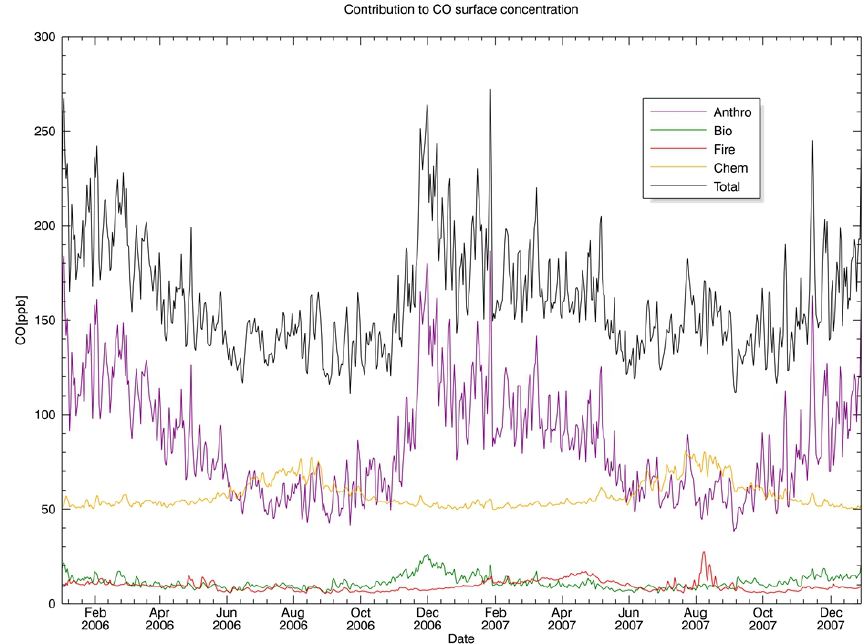
Fig. 10. CO contributed from each source type and total CO (black) as simulated by MOZART for 2006–2007. Each source represents the global contribution of a specific type. Anthropogenic sources (purple) are the main contributors to the total CO and have similar seasonal cycle as the total CO and large daily variability. Chemically produced CO (orange) have an opposite seasonal cycle (high over summer) and relatively small daily variability. Biogenic (green) and fires (red) have small daily variability.